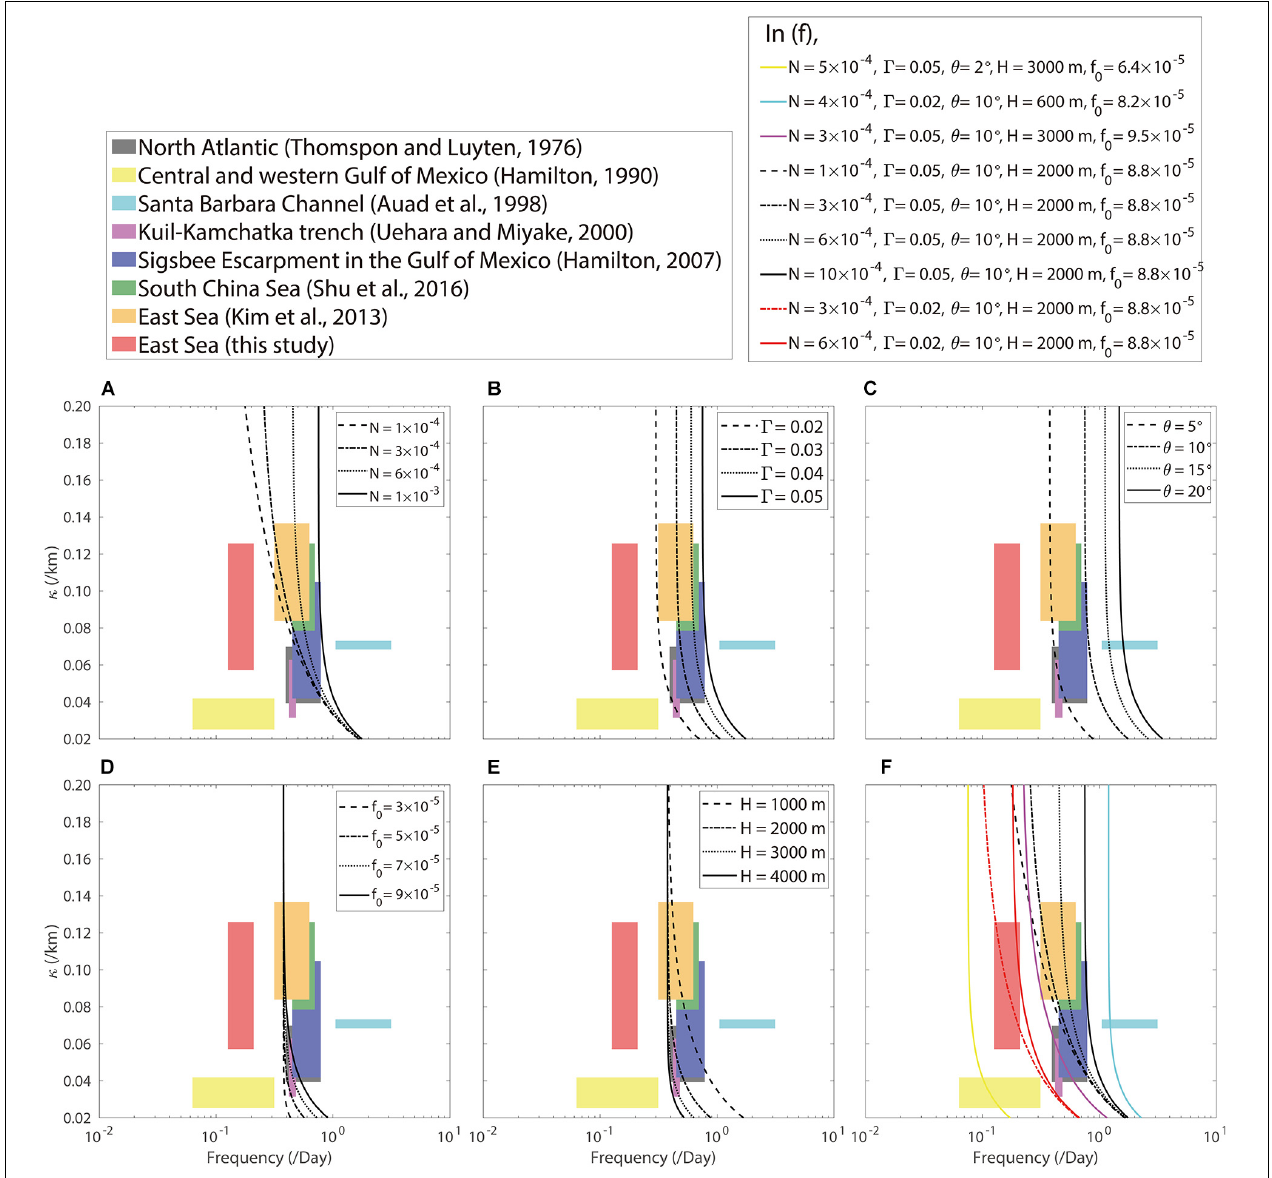
FIGURE 1 | Dispersion relation (lines) of bottom-trapped TRWs from Eq. (1) for (A) varying buoyancy frequency ( N ) with constant bottom slope ( (cid:48) = 0 . 05), propagating orientation angle rotated from the isobath direction ( θ = 10 ◦ ), Coriolis parameter ( f 0 = 8.8 × 10 - 5 s - 1 ), and depth level ( H = 2000 m); (B) varying (cid:48) with constant N (= 1 × 10 - 3 s - 1 ), θ (= 10 ◦ ), f 0 (= 8.8 × 10 - 5 s - 1 ), and H (= 2000 m); (C) varying θ with constant N (= 1 × 10 - 3 s - 1 ), (cid:48) (= 0.05), f 0 (= 8.8 × 10 - 5 s - 1 ), and H (= 2000 m); (D) varying f 0 with constant N (= 1 × 10 - 3 s - 1 ), (cid:48) (= 0.05), θ (= 10 ◦ ), and H (= 2000 m); (E) varying H with constant N (= 1 × 10 - 3 s - 1 ), (cid:48) (= 0.05), θ (= 10 ◦ ), and f 0 (= 8.8 × 10 - 5 s - 1 ); and (F) their combinations. Herein, ranges of wavenumbers ( κ ) and frequencies ( ω ) investigated in past and present studies are shaded with different colors, and references are presented. √ current speed ( u (cid:48) 2 + v (cid:48) 2 ) was calculated using Welch’s power spectrum methods (Welch, 1967) and Hamming windows with 50% overlap. In addition to the moored current-meter data, vertical profiles of temperature and salinity collected in the eastern UIG (near U5 and EC1) from six full-depth CTD